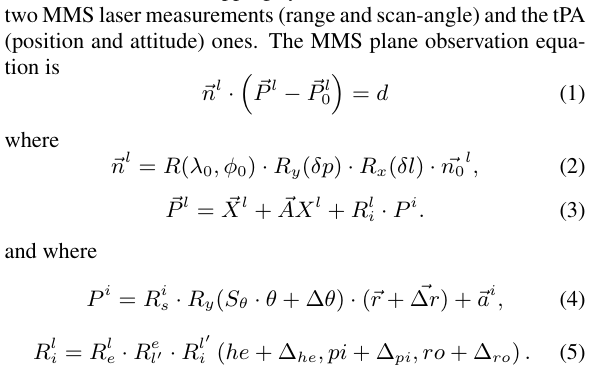
Table 2: Symbols in the MMS plane observation